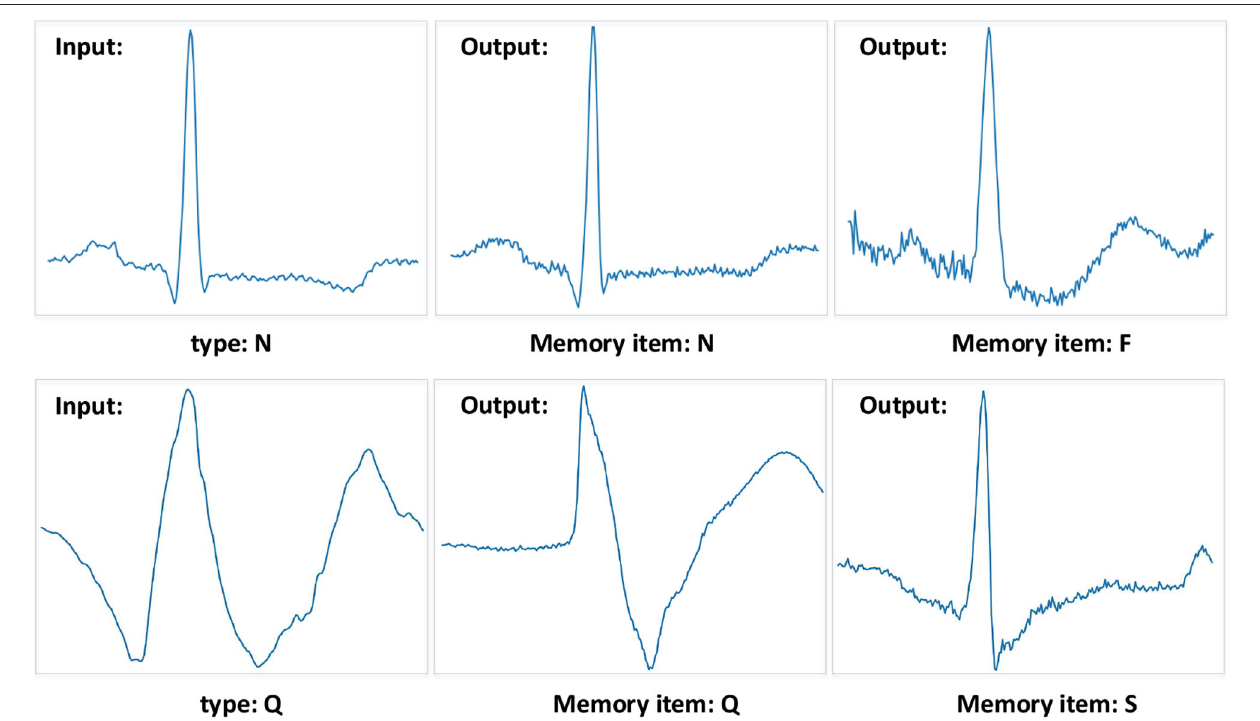
FIGURE 9 | Examples of the MIT-BIH Arrhythmia database. The “N” type and “Q” type are set to the input samples. And the different memory items mean that the training phase records corresponding types of features. The MAE model can get a significant reconstruction error when the input data is different from the recorded data